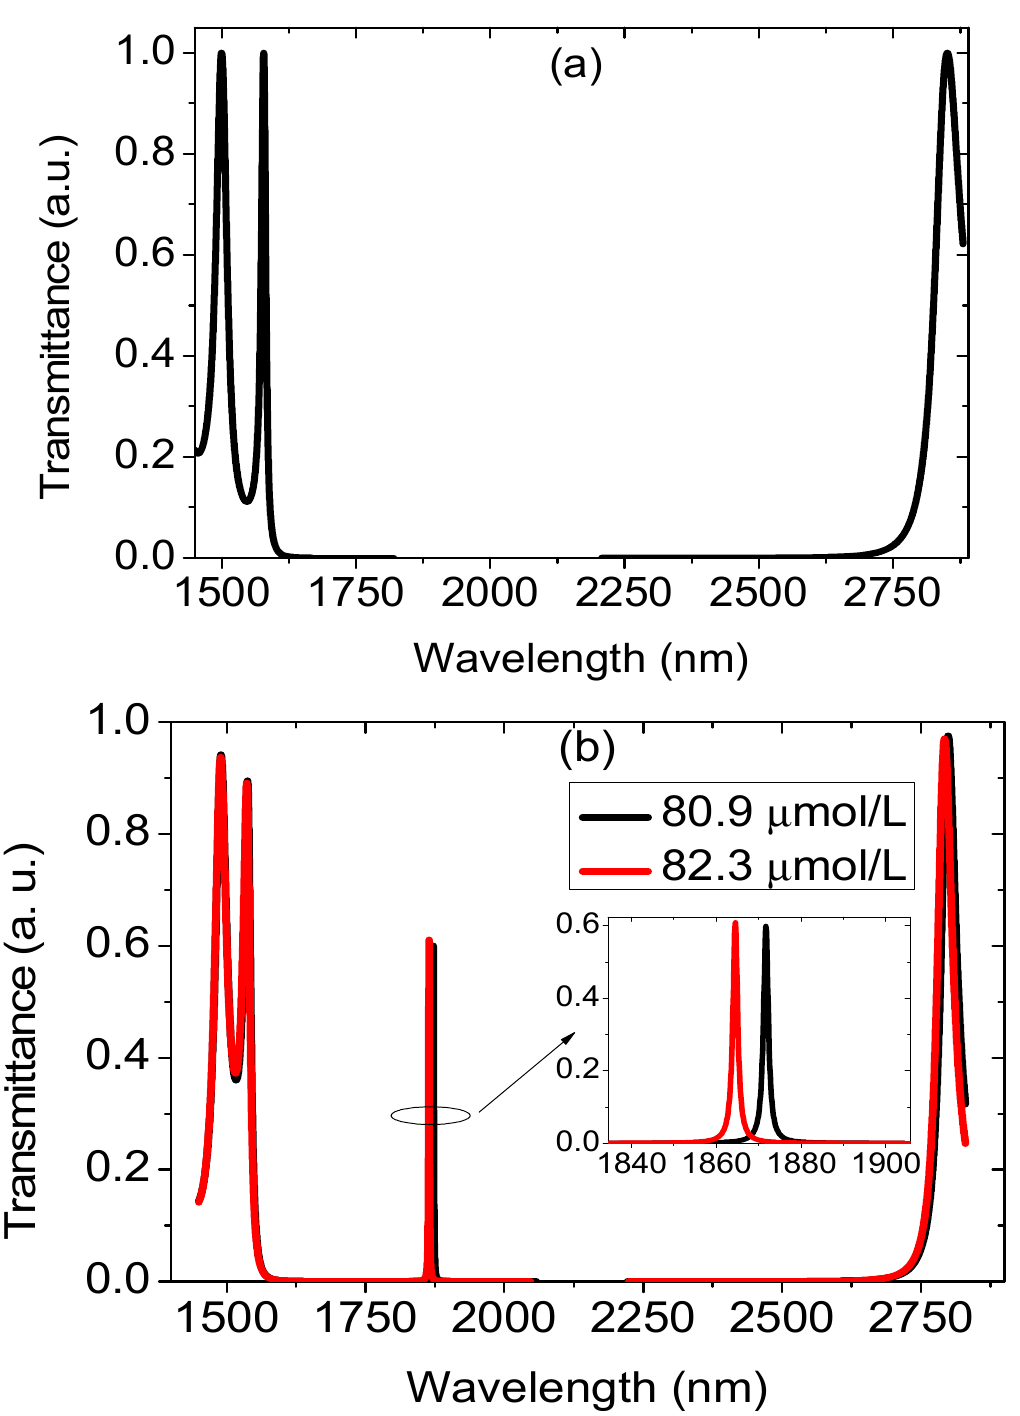
Figure 3. Transmittance spectra of TPC ( a ) without a defect medium; ( b ) with a defect medium at θ 0 = 0.0°, h 1 = 120 nm, h 2 = 260 nm, h 3 = 190 nm, h 3 = 500 nm, n 1 = 3.3, n 2 = 1.28, n 3 = 1.46.